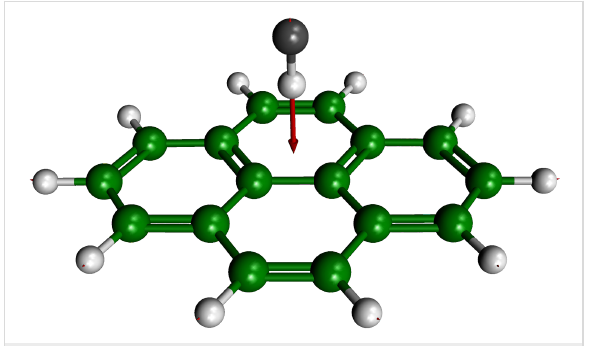
Figure 6: Hydrogen fluoride adsorbed on a pyrene molecule. The arrow represents the HF stretching mode.